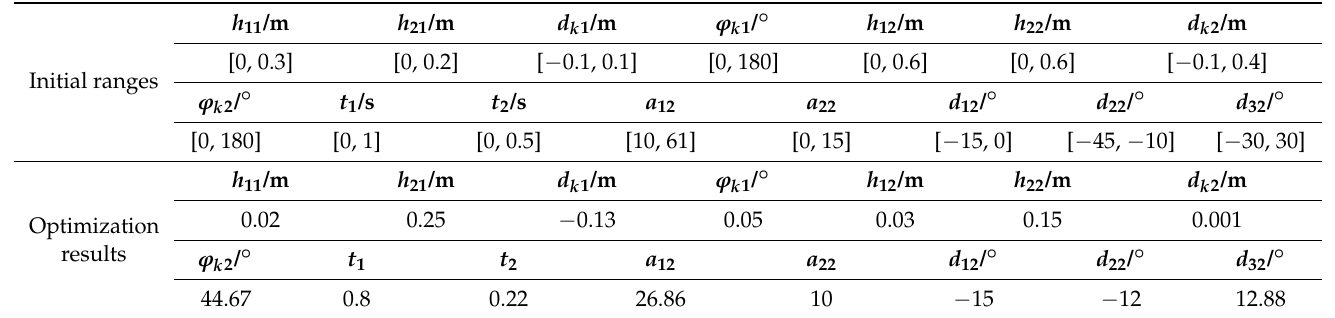
Table 5. Initial parameter ranges and optimization results for example